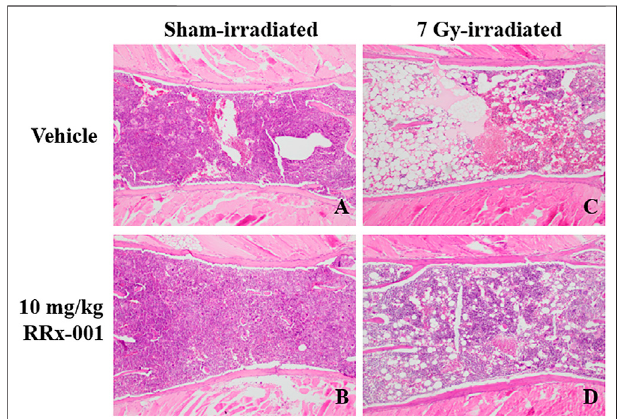
FIGURE 4 | Photomicrographs of H&E stained thin sections of bone marrowsternashowingrepresentativebonemarrowcellularityinallgroupson day 14. Panels (A) and (B) : Bone marrow sterna pretreated with either vehicle or 10 mg/kg RRx-001 on day 14 after sham-irradiation. Panel (C) : Vehicle-treated sternal bone marrow 14 days after sublethal irradiation illustrated severe hypocellularity as evident by marrow space demonstrating only residual stromal fat (visualized as increased marrow white space). Panel (D) : RRx-001-treated sternal bone marrow 14 days after sublethal irradiation showed signi fi cantly increased cellularity asseen by theincreased amounts of cells stained purple and decrease in the visualized stromal adipose tissue (white space) ( × 100 magni fi